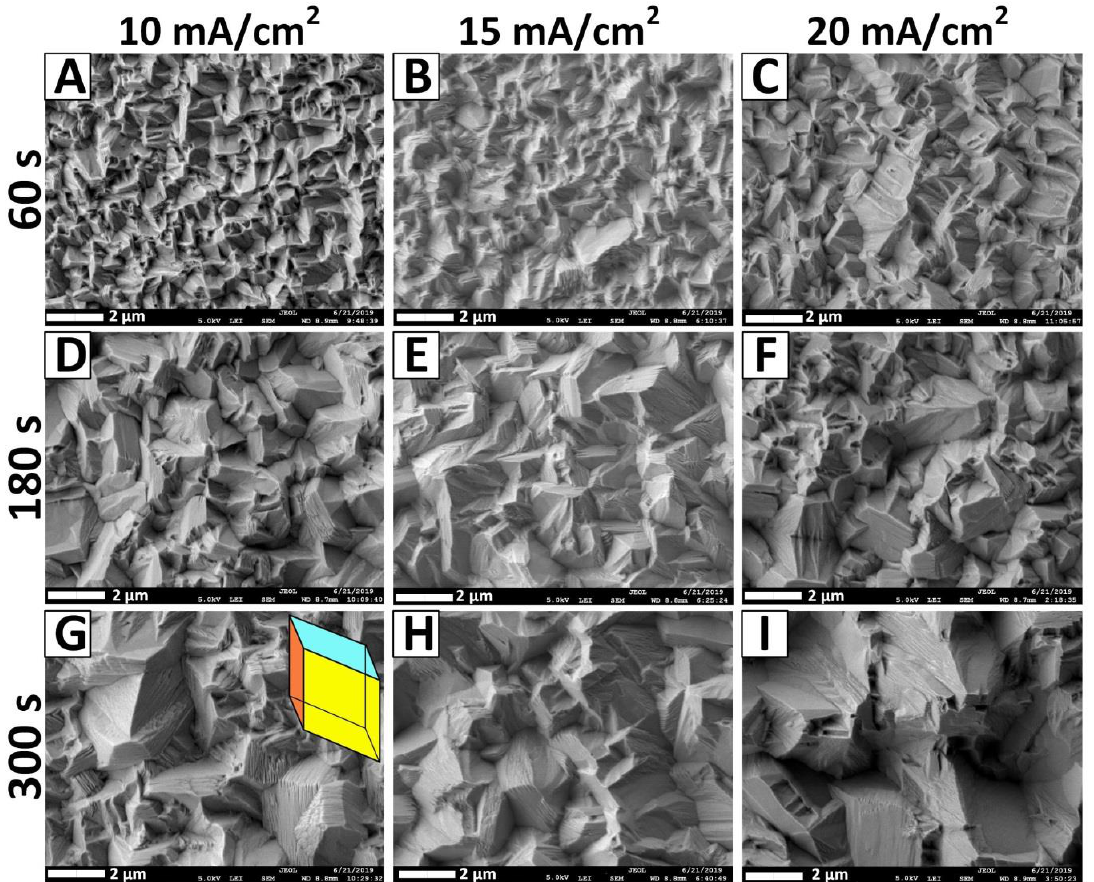
Figure 5. SEM images of Bi films surface electrodeposited from PE with 10 mA / cm 2 ( A , D , G ), 15 mA / cm 2 ( B , E , H ), and 20 mA / cm 2 ( C , F , I ) current density, and deposition duration of 60 s ( A – C ), 180 s ( D – F ), and 300 s ( G – I